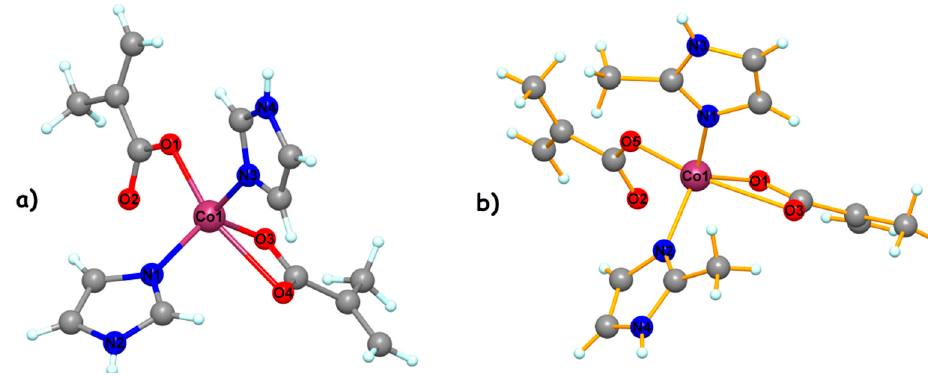
Figure 1. The asymmetric unit for compound ( 1 ) ( a ) and compound ( 2 ) ( b ).